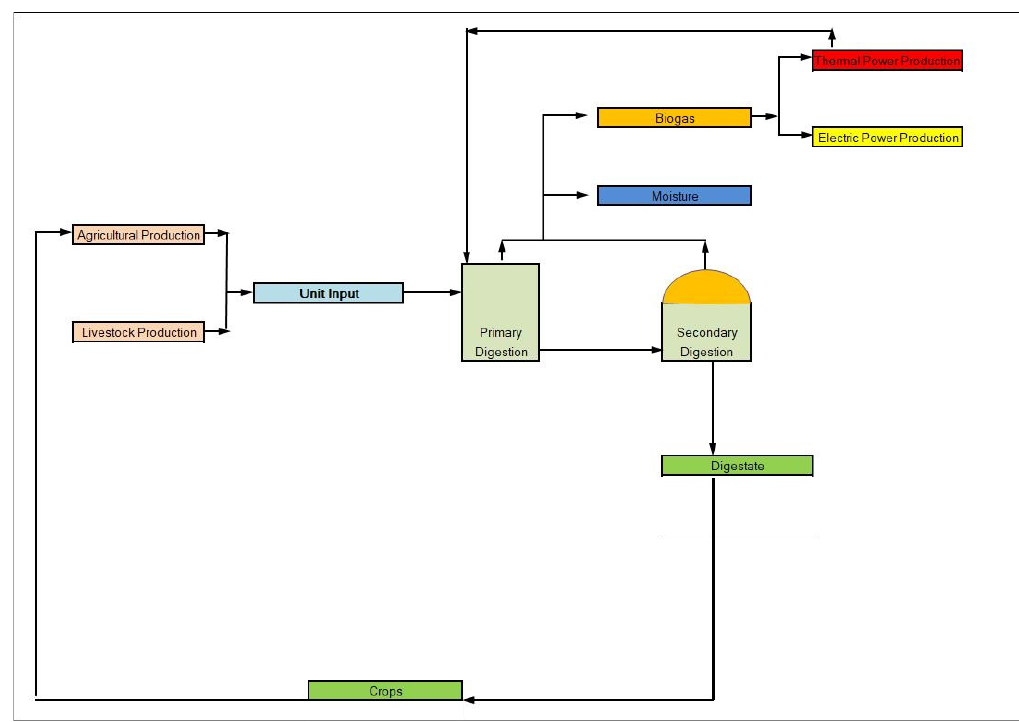
Figure 1. Process flowchart of a typical biogas plant from agricultural and livestock production.